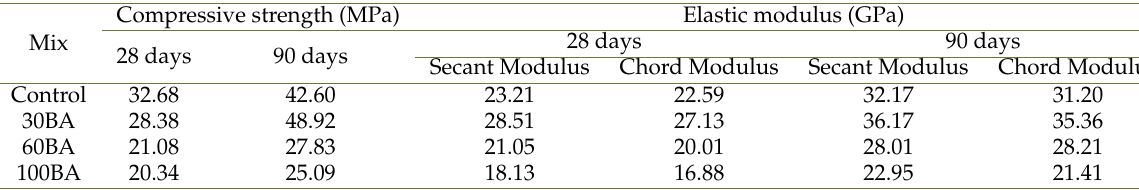
Table 7. Values of DS.